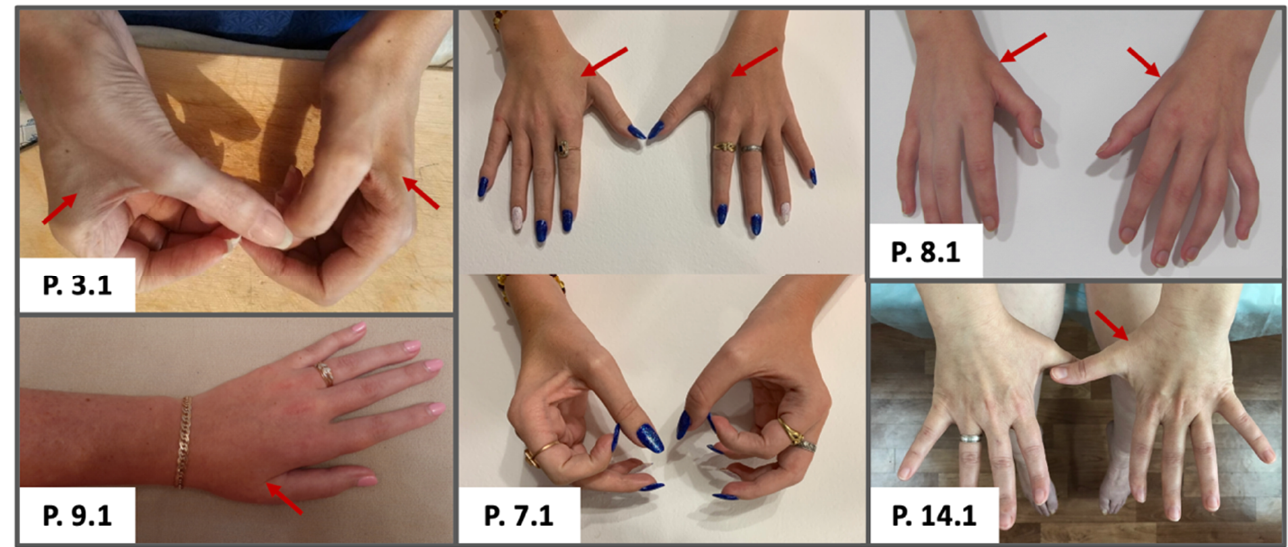
Figure 2. Hands of GNEM patients. Prominent atrophy of hand muscles, especially first dorsal interosseus, are noted with arrows.